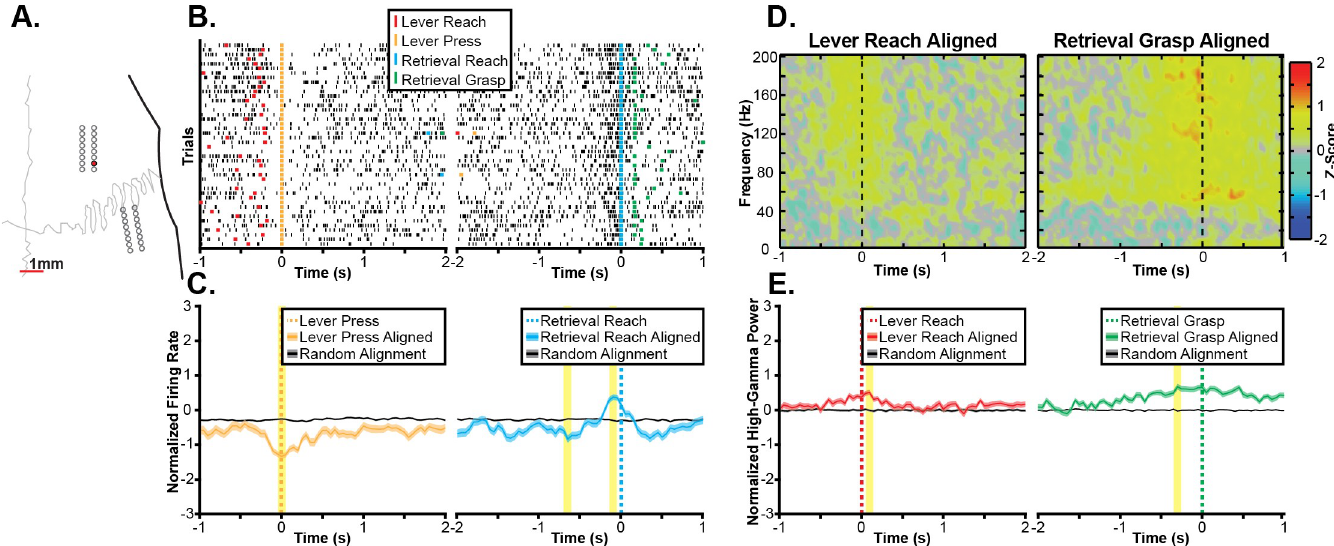
Fig 6. Exemplar press-related channel. A. Task-related neural activity is shown for an exemplar channel from the RFA array of Rat 5 as shown by the red electrode in the topographic plot. B. Raster plots show multi-unit spike times (black ticks) aligned to the lever press (left) and onset of the reach to the pellet (right), showing a decrease in firing rate correlated to the lever press followed by an increase in firing rate prior to the reach to the pellet. C. Multi-unit firing rates were estimated by counting spike times within 100 ms windows shifted by 50 ms between windows and then averaging across trials. Mean firing rates show a complex task response with firing rates significantly (p < 0.05) decreased around the lever press and 650 ms prior to the reach to the pellet and then significantly increased immediately prior to the reach to the pellet. The statistically significant peak firing rates are indicated by the yellow highlighting. D. Spectral power changes are plotted aligned to the reach to the lever (left) and pellet grasp (right). Spectral power changes were log transformed and z-scored relative to randomly selected time windows between trials, therefore, positive values indicated increases in spectral power, and negative values indicate decreases in spectral power. A broadband increase in spectral power in frequencies above 60Hz was observed for the grasp of the food pellet (right) with a lower amplitude increase in broadband spectral power observed before the reach to the lever. E. High-gamma band (70Hz-110Hz) power did not show a decrease around the lever press but instead showed a small, but statistically significant (p < 0.05), increase in high-gamma band power prior to the reach to the lever. The high-gamma band power maintained the significant increase in activity near the time of the pellet retrieval observed in the multi-unit firing rate. The statistically significant peak modulations of high-gamma band spectral power are indicated by the yellow highlighting.